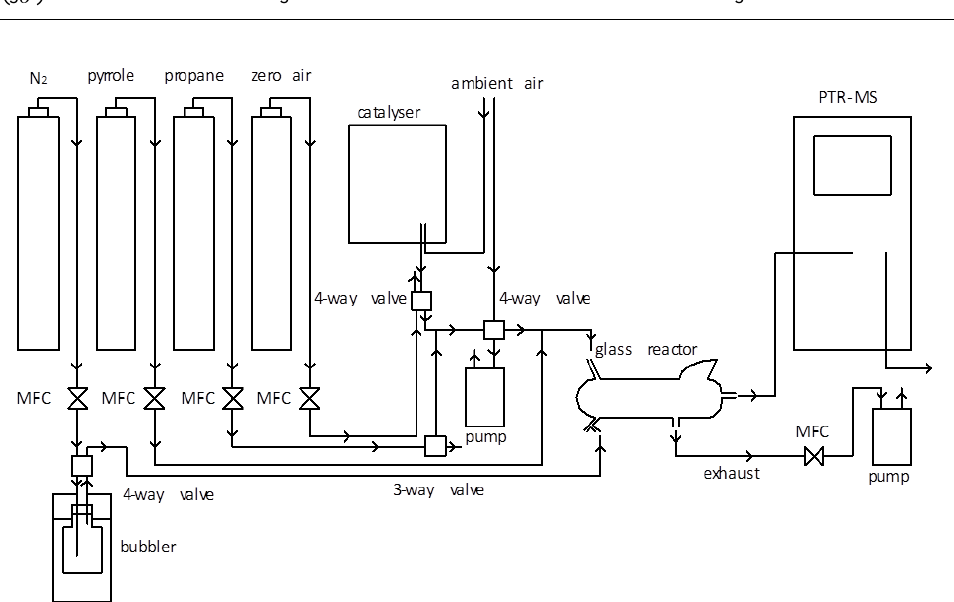
Figure 3. Simplified not-to-scale schematic of the comparative reactivity method instrument of LSCE. Known flows of pyrrole, N 2 , and zero air are injected into a glass flow reactor. A four-way manual valve is used to humidify the flow of nitrogen, when OH radicals production is required. A four-way automatic valve allows for fast switches between C2 and C3 stages. A known amount of an external standard (in this case, propane) can be injected in the reactor to calibrate the instrument through a three-way